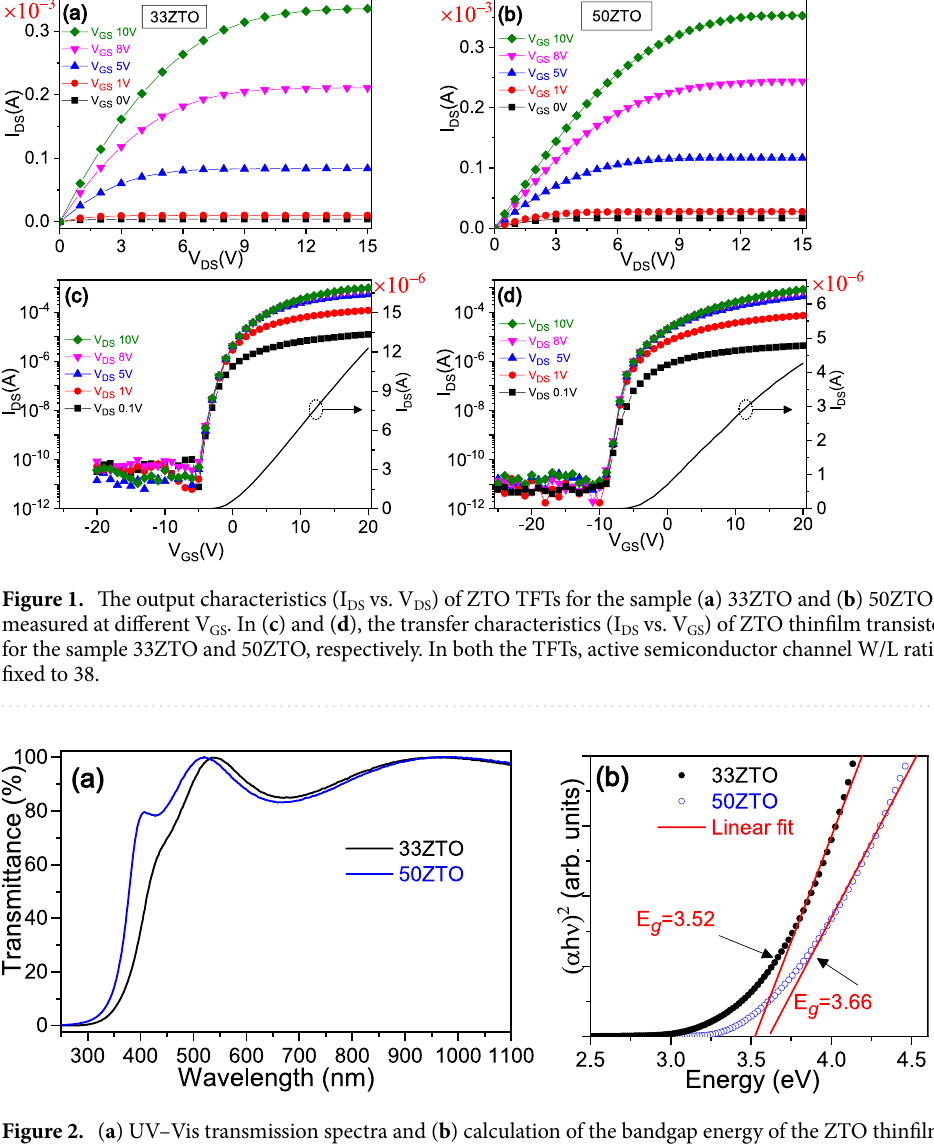
Figure 2. ( a ) UV–Vis transmission spectra and ( b ) calculation of the bandgap energy of the ZTO thinfilms on Corning glass substrate with an elemental composition identical to semiconductor channels of 33ZTO and 50ZTO